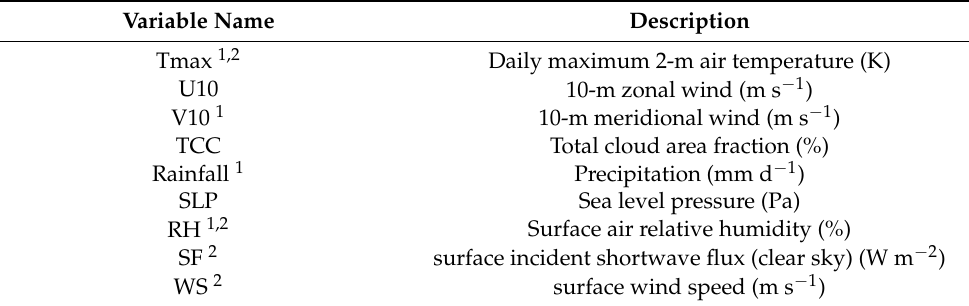
Table 3. Meteorological variables that are considered ozone covariates.